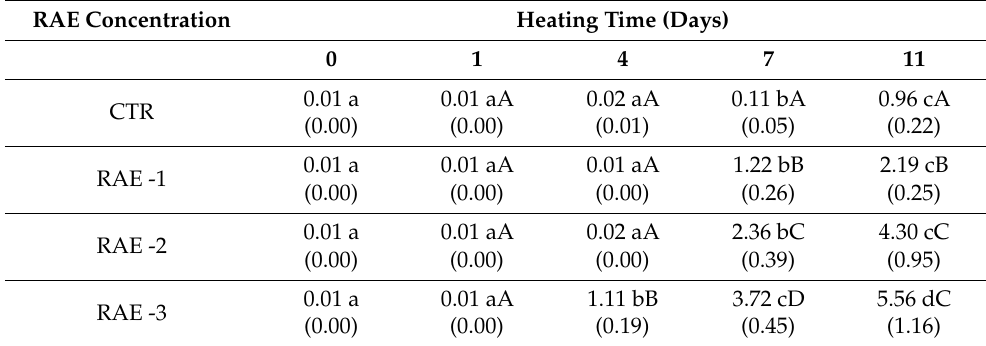
Table 3. The determination of free fatty acid (FFA; g · kg − 1 lipids) content in fish muscle heated in the presence of red alga extract (RAE)